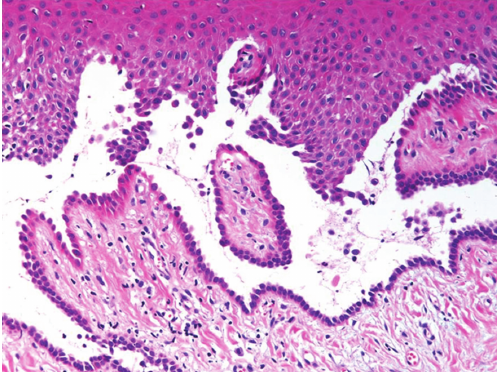
Figure 4: Histopathologic examination of specimens from the gingiva. Suprabasial acantholysis near the tips of two adjacent rete pegs is